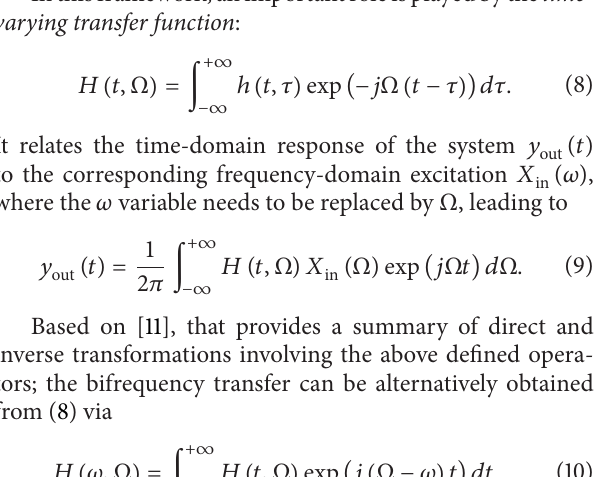
From the previous result, the bifrequency transfer func- tion 𝐻 (𝜔, Ω) can be considered as a map between the input (Ω) and the output 𝑌 (𝜔) , where the variables Ω and 𝜔 𝑋 in out are the input and output frequencies,